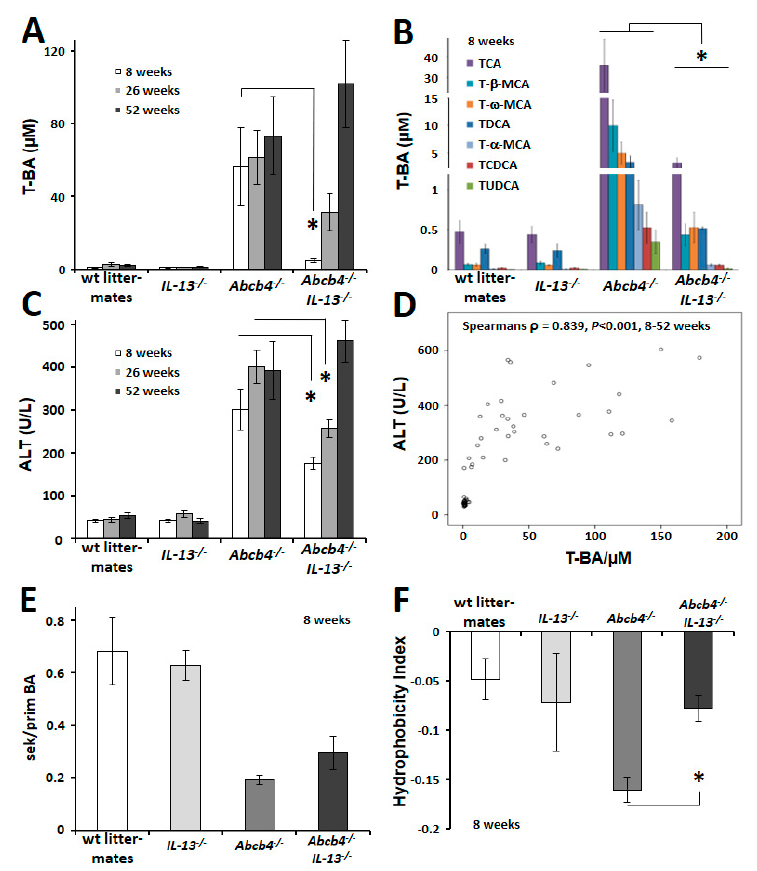
Figure 2. IL-13 -knockout reduced serum bile acid concentrations and improved hepatic integrity. ( A ) IL-13-knockout transiently reduced serum bile acids in Abcb4 − / − / IL-13 − / − mice. ( B ) The seven most prominent serum bile acids were significantly reduced in 8-week-old Abcb4 − / − / IL-13 − / − mice. Wt and IL-13 − / − controls n = 3–4, Abcb4 − / − and Abcb4 − / − / IL-13 − / − n = 4–6. Please note the two scale breaks in the y -axis. ( C ) Serum biochemical parameter of hepatocellular injury (ALT) decreased in Abcb4 − / − / IL-13 − / − mice of 8 and 26 weeks but adjusted to Abcb4 − / − -serum levels at 52 weeks of age. n = 8–12. ( D ) Serum ALT correlated well to serum bile acid concentrations (8, 26, and 52 weeks). ( E ) The ratio between secondary and primary serum bile acids was not altered by IL-13 knockout in Abcb4 − / − mice at the age of 8 weeks. ( F ) The hydrophobicity index was normalized in Abcb4 − / − / IL-13 − / − mice aged 8 weeks. Values are means ± SEM. * p < 0.05 Abcb4 − / − vs Abcb4 − / − / IL-13 − / − . Abbreviations used are: T-BA, taurine conjugated bile acids; wt, wild type.